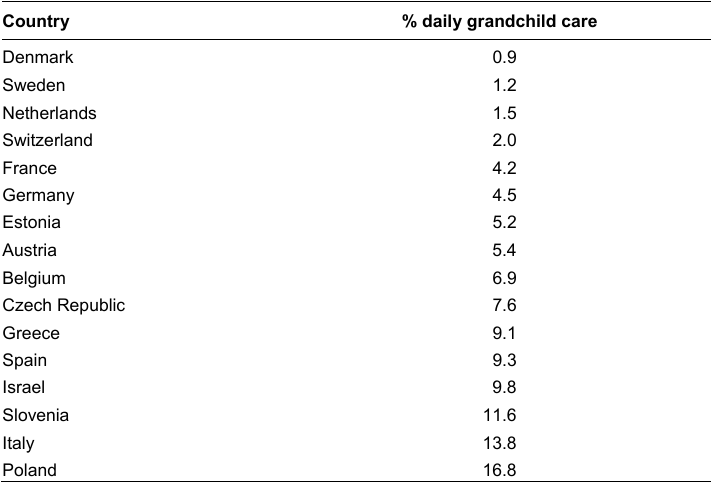
Table A2 : Percentage of respondents providing grandchild care on a (almost) daily basis, by